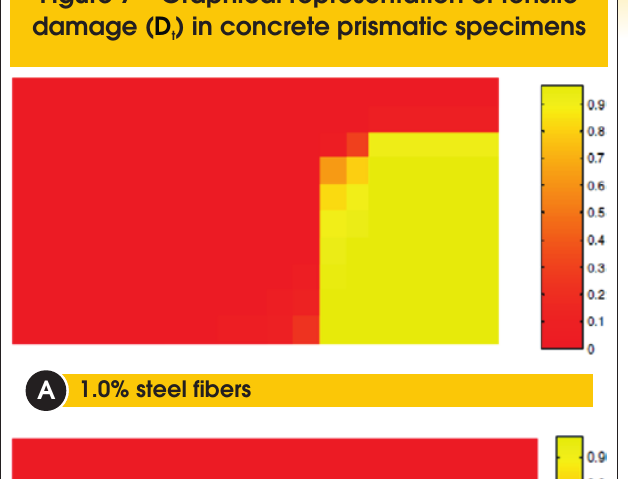
Figure 7 – Graphical representation of tensile D damage ( ) in concrete prismatic specimens t